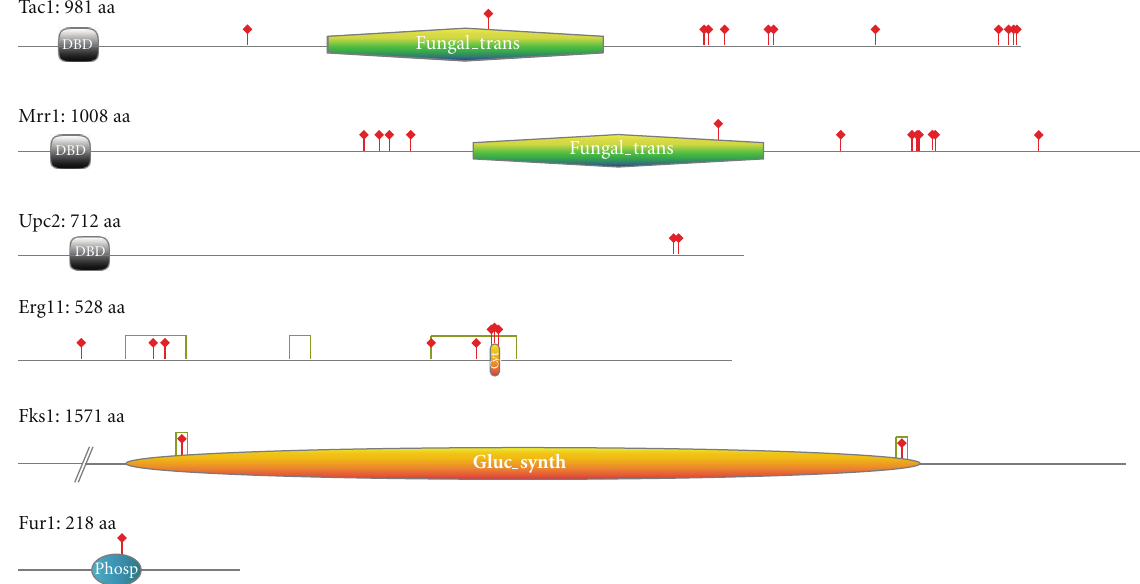
Figure 9: Point mutations a ff ecting antifungal susceptibility in clinical isolates of C. albicans . Indicated functional domains were determined using either Prosite or Pfam tools. Only mutations which involvement in antifungal resistance was experimentally demonstrated are indicated by a red stick. Hot spot mutations in Erg11 and Fks1 are delimitated by gray boxes (Point mutation localization references: Tac1 [112], Mrr1 [133], Upc2 [134], Erg11 [135], Fks1 [136], Fur1 [137]). Drawings of the proteins were made with Prosite My Domain-Image Creator